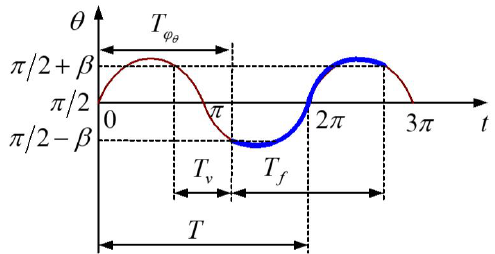
Figure 3. Diagram of the angular motions of the hopping